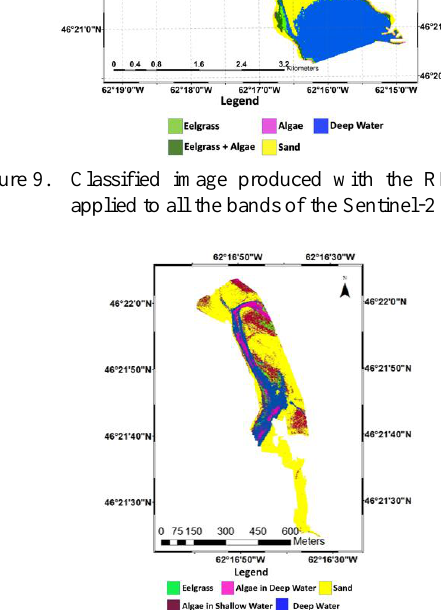
Figure 11. Variable importance plot for the Sentinel-2 image classification with RF